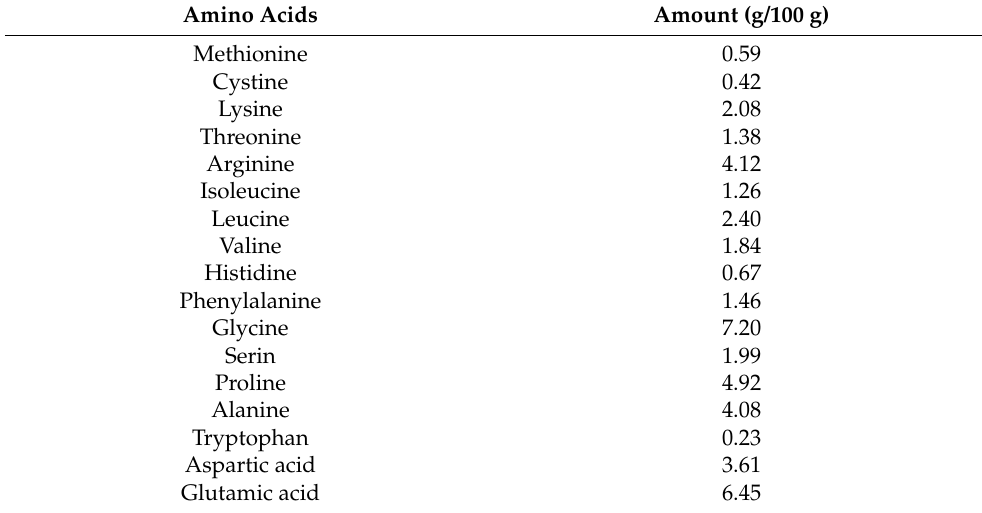
Table 3. The amino acid composition of the Agro-Matic protein concentrate.